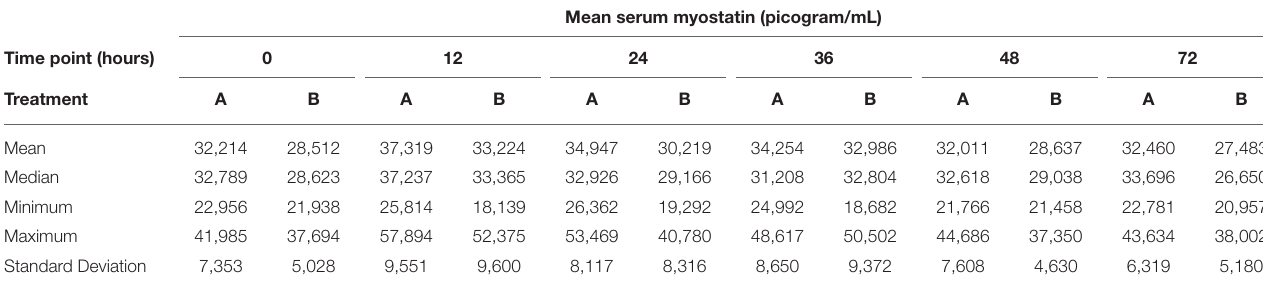
TABLE 4 | Phase 2 high dose Fortetropin vs. Placebo: Mean, median, minimum, and maximum serum myostatin concentrations